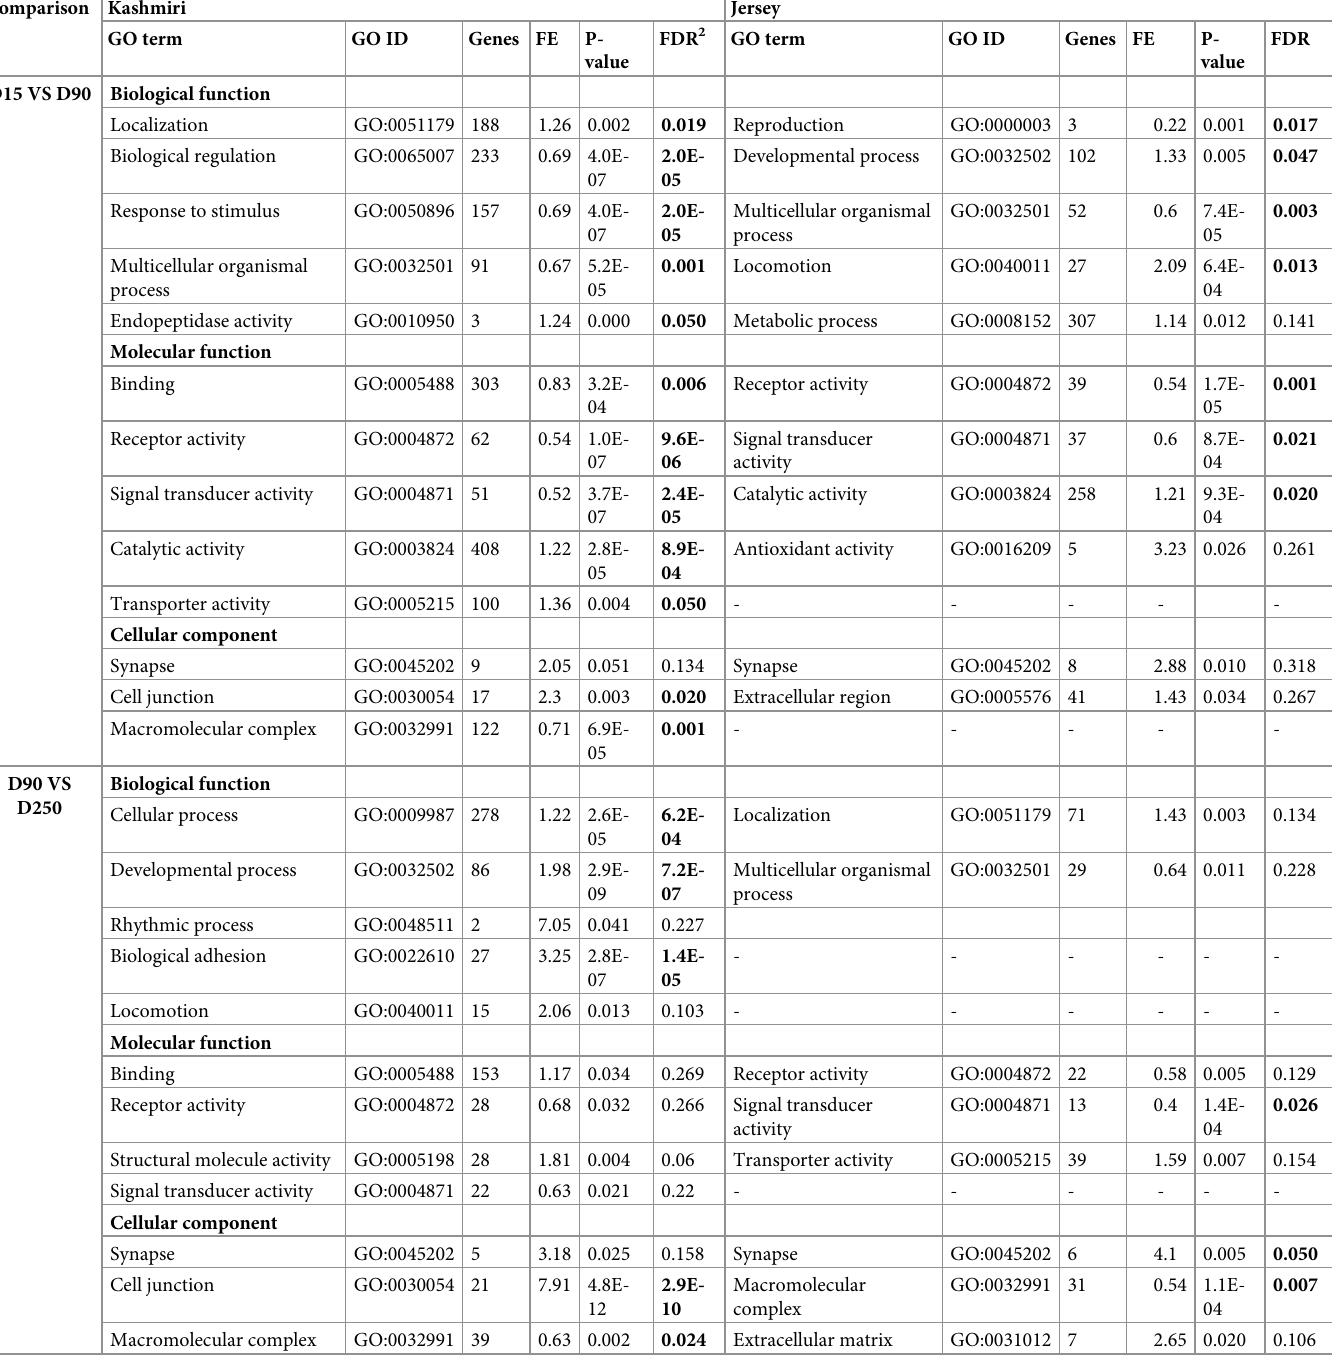
Table 6. Significantly enriched gene ontology (GO) terms associated with identified differentially expressed genes in mammary epithelial cells in Kashmiri and Jer- sey cattle 1 . Comparison